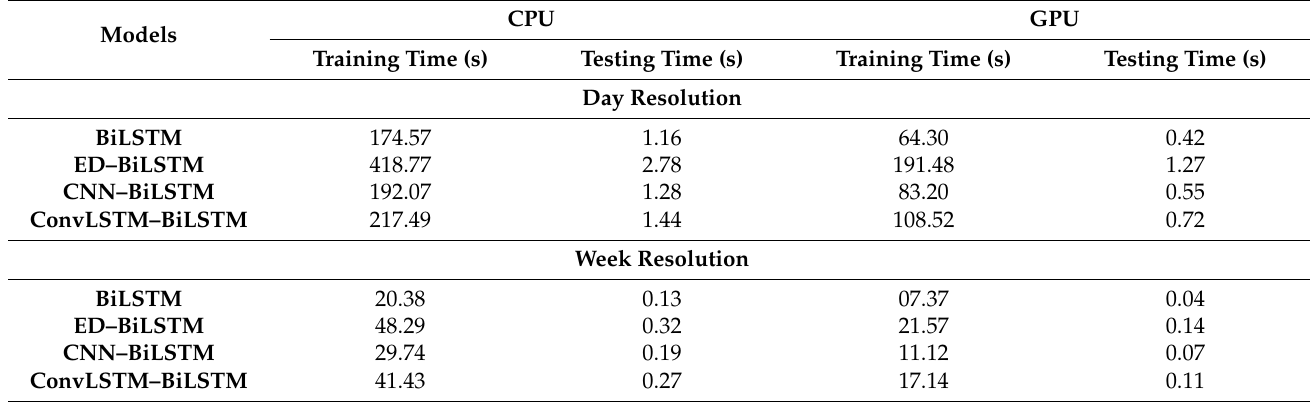
Table 8. Comparative analysis of the sequential models based on time complexity in seconds (s) over Household Dataset.